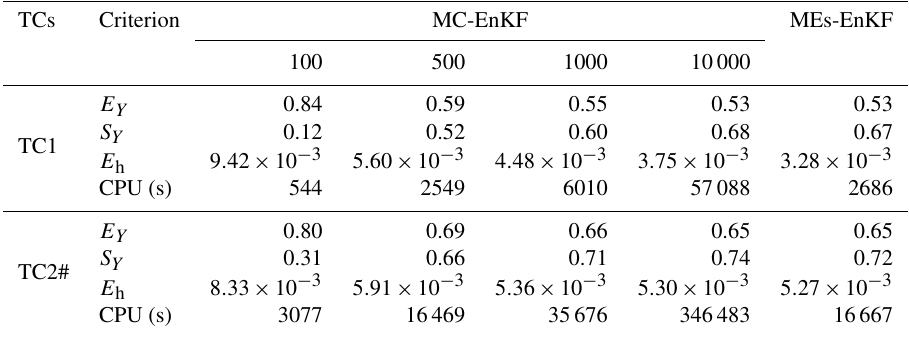
Table 2. Comparison of results obtained by the MEs-EnKF and MC-EnKF (based on 100, 500, 1000, and 10000 realizations) for TC1 and